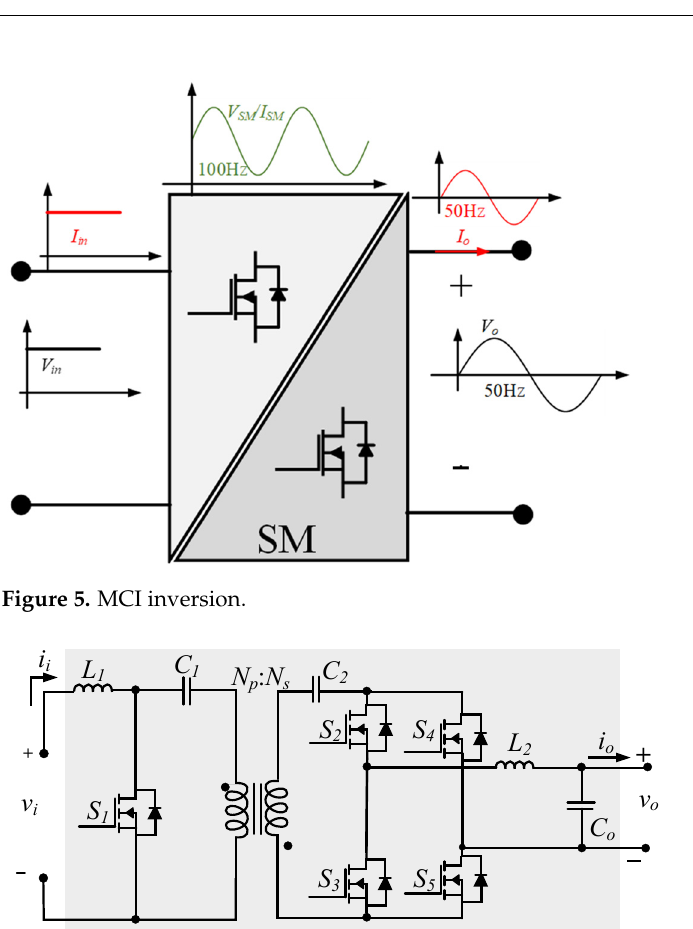
Figure 6. Cuk-based MI with isolation.